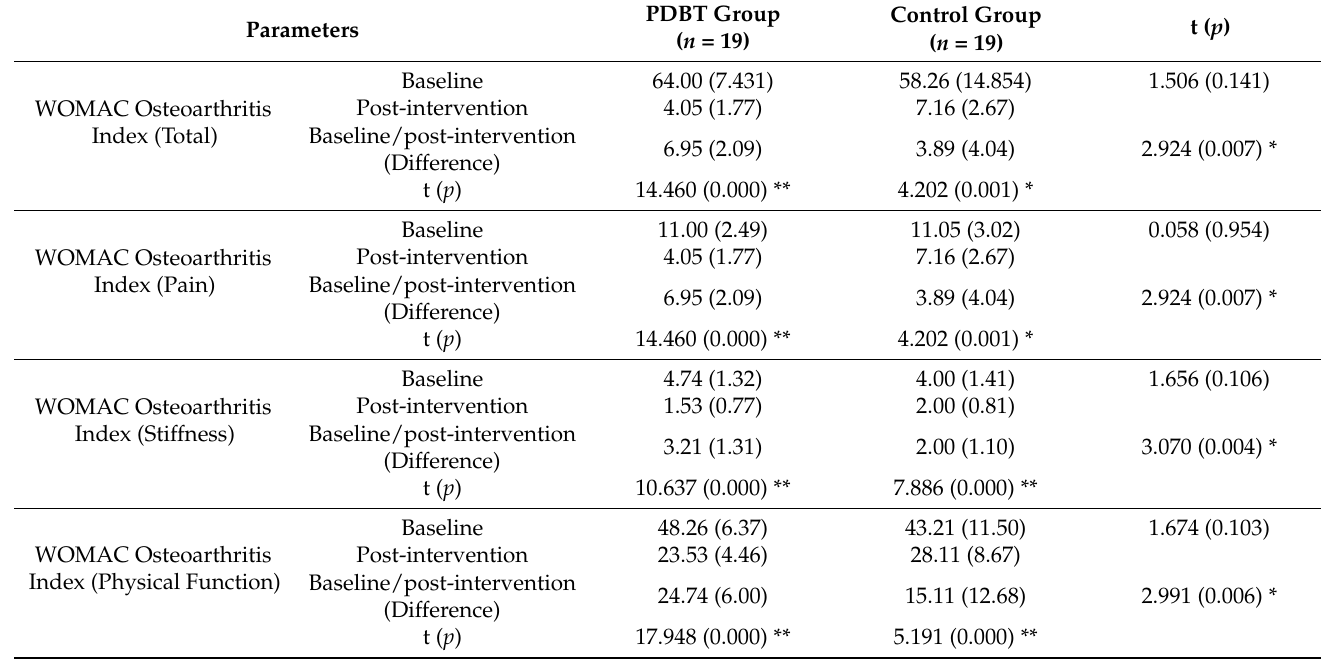
Table 2. Comparison of physical function within and between the groups ( n =